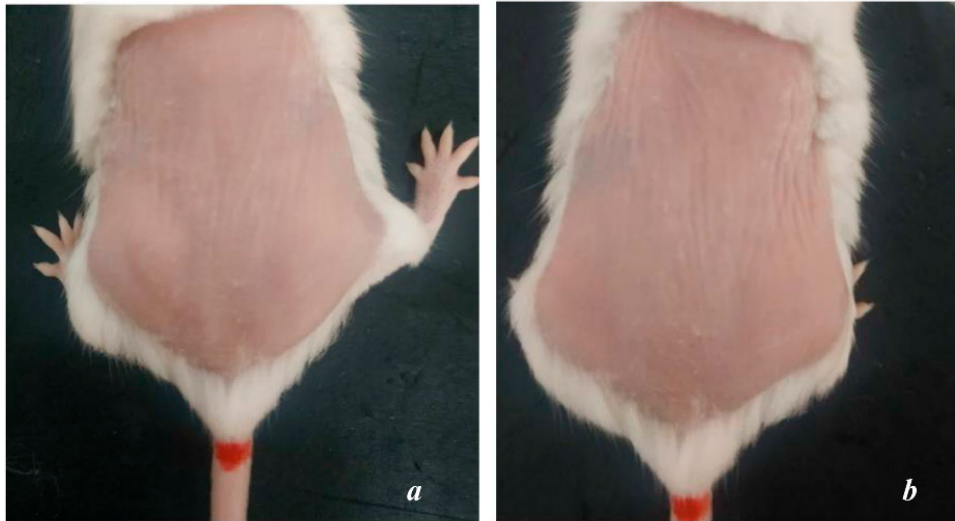
Figure 1. Mouse skin after 8 weeks of UVA exposure: (( a )—PC; ( b )—NC).( a )The PC group showed many statistically significant superficial wrinkles.( b ) NC group dry skin, uneven skin tone, deep wrinkles and a lot.